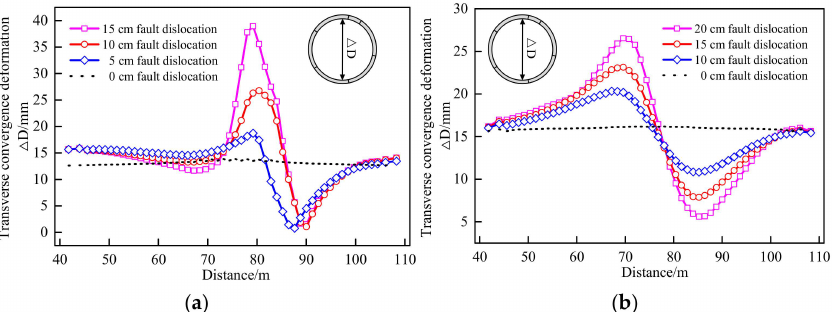
Figure 16. Transverse convergence deformation of a shield tunnel under faulting: ( a ) normal faulting condition and ( b ) reverse faulting